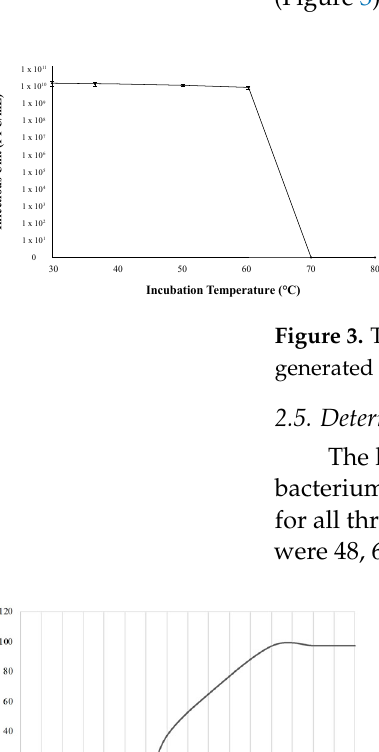
Figure 5. Effects of different treatments of bacteria on phage absorption, shown as residual PFU percentages. Effect of proteinase K treatment and sodium periodate treatment on the absorption of ( A ) KaiHaiDragon, ( B ) OneinaGillian, and ( C ) YuuY to M. foliorum . Error bars depict the standard deviations between the titers generated from three independent assays. 2.7. Genomic Characteristics of Microbacterium Phages The genome lengths, GC% content, termini, and lytic life cycles of KaiHaiDragon, OneinaGillian, and YuuY were used to categorize them into Cluster EC, Cluster EG, and Subcluster EA10, respectively (Table 2). OneinaGillian has direct terminal repeats while KaiHaiDragon and YuuY have circularly permuted termini, consistent with headful pack- aging systems. Phages OneinaGillian and YuuY have each half of their genome tran- scribed in different directions, while phage KaiHaiDragon has all of its open reading frames (ORF) transcribed in the same direction (Figure 6).